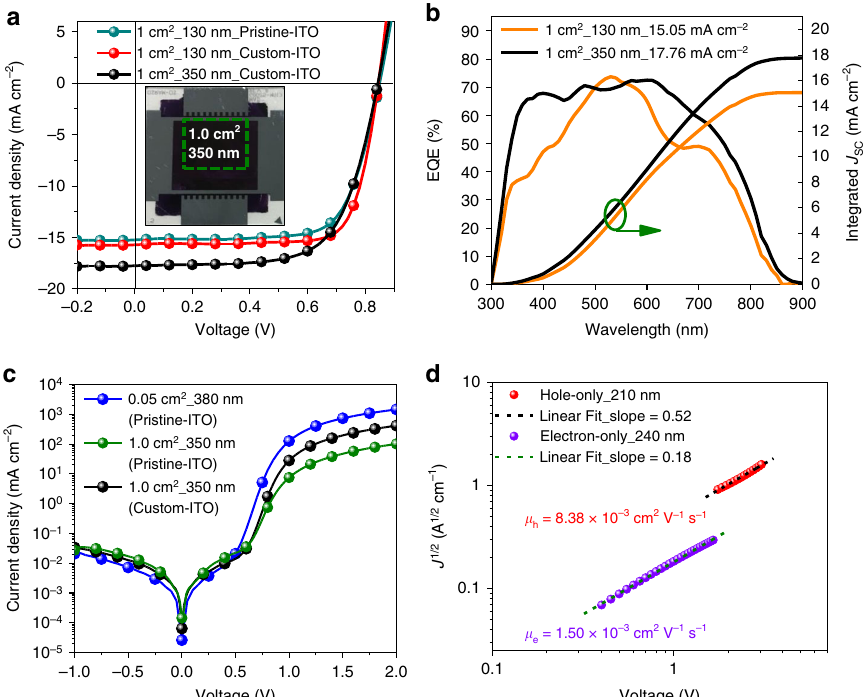
Fig. 4 Photovoltaic performance for large-area cells. a J – V characteristics for 1-cm 2 cells with different substrate and varied AL thickness, inset is photo of 350-nm cell on a custom-ITO layout (2.5 × 2.5 cm 2 ). b EQE curves and integrated current density for 1-cm 2 cells (custom-ITO). c Dark J – V curves for 0.05-cm 2 and 1-cm 2 cells in thick- fi lm condition. d J 1/2 -V characteristics for hole- and electron-only